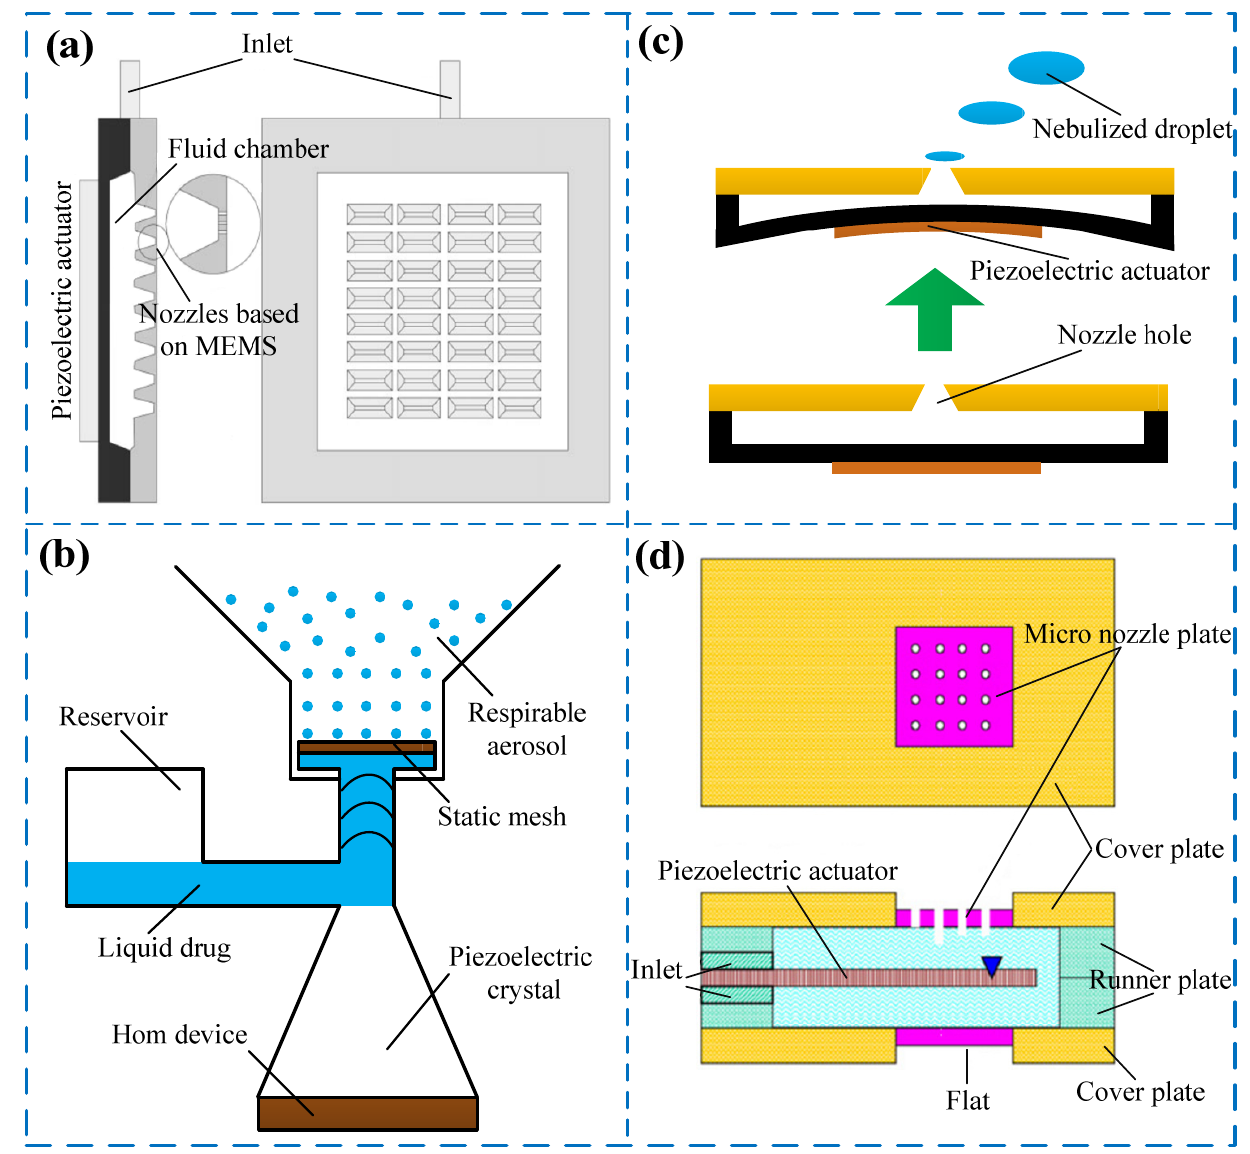
Figure 2. Static mesh atomizer: ( a ) a SMA by Heij et al. [42], reprinted with permission from Ref. [42]. Copyright 2000 Elsevier, ( b ) an innovative SMA adapted from Pan et al. [47], ( c ) a SMA adapted from Vecellio [46], and ( d ) a new structure SMA by Jeng et al. [48,49], reprinted with permission from Ref [48,49]. Copyright 2007